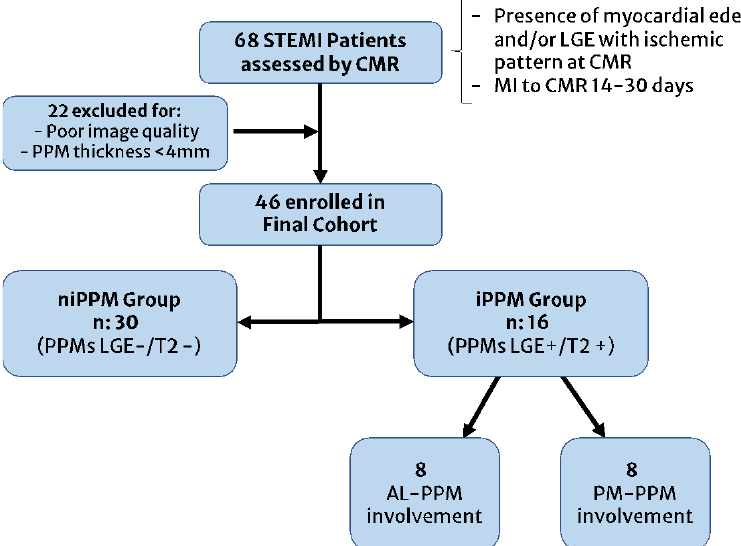
Figure 2. Patients recruitment flowchart. STEMI: ST-elevation myocardial infarction; CMR: cardiac magnetic resonance; LGE: late gadolinium enhancement; MI: myocardial infarction, PPM: papillary muscle; AL: anterolateral; PM: posteromedial.